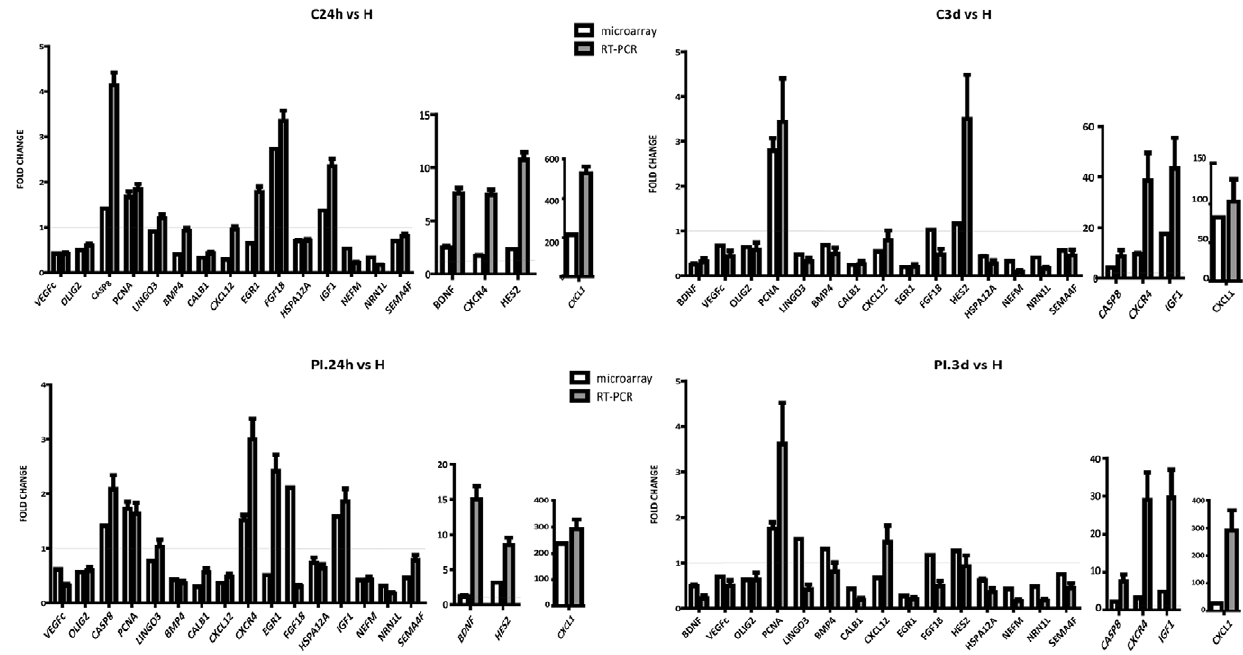
Figure 6. Validation of data from microarray analysis. The levels of 19 representative genes were assessed by qRT-PCR in a new set of 12 animals. Values were normalized to GAPDH, PGK1 and HMBS control genes. Data represent the means 6 SD of three independent experiments performed in triplicate. Differences with healthy animals were arbitrarily set to 1. All changes in gene expression were significant ( P , 0.01). Red line indicates